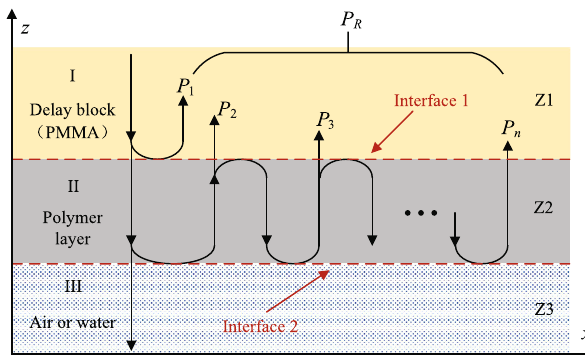
Fig. 1 Schematic diagram of vertical incidence of ultrasonic to a three-layer